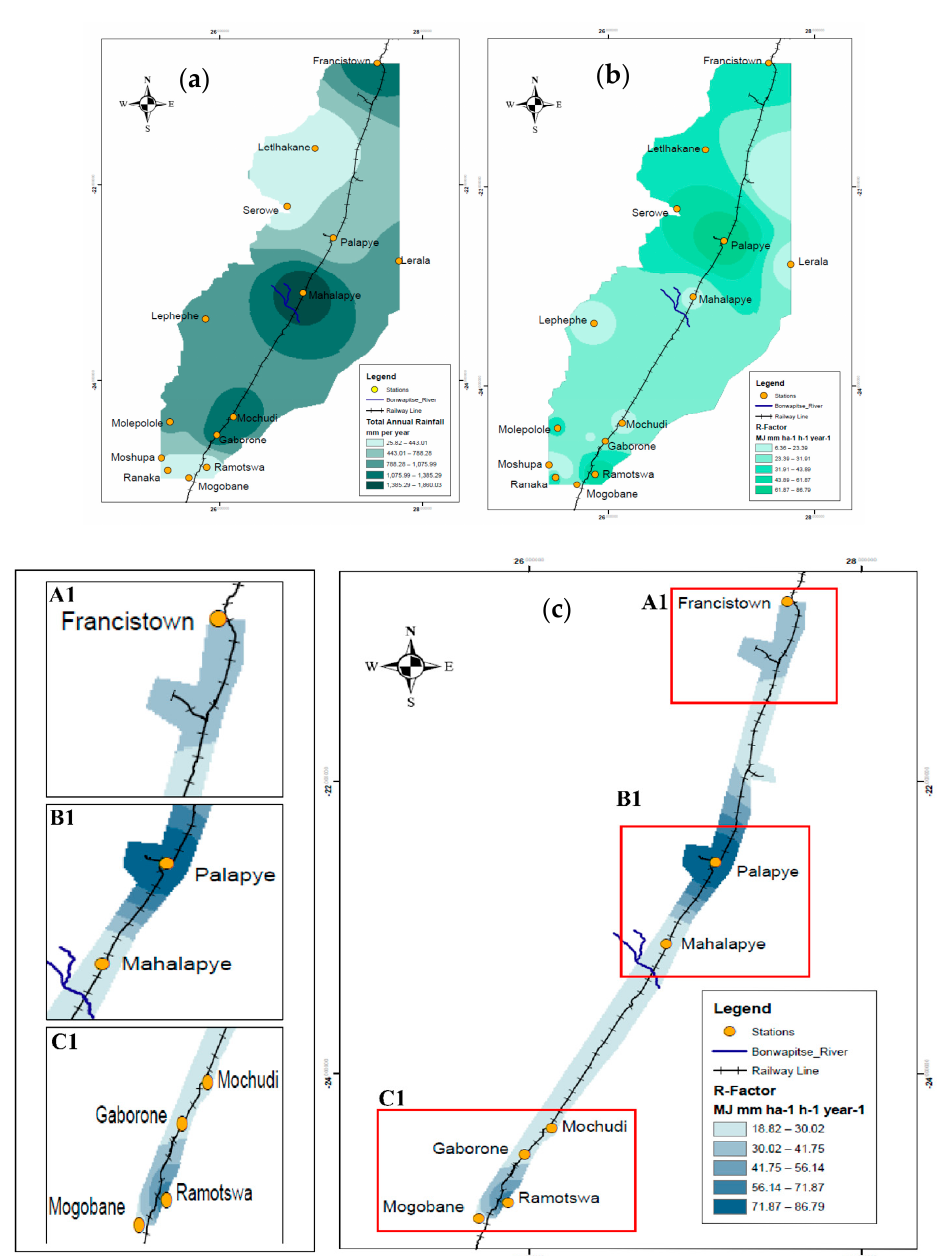
Figure 4. ( a ) Average annual rainfall. ( b ) R-factor for basin. ( c ) R-factor for the 200 m railway corridor (BRC).